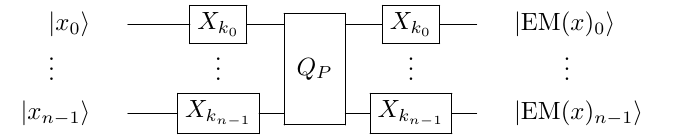
. If k 0 = 1 we place a NOT-gate X . i 2